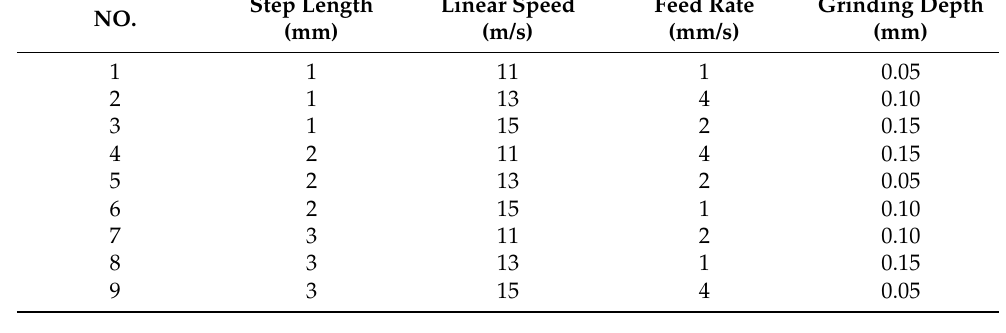
Table 3. Orthogonal test parameters.